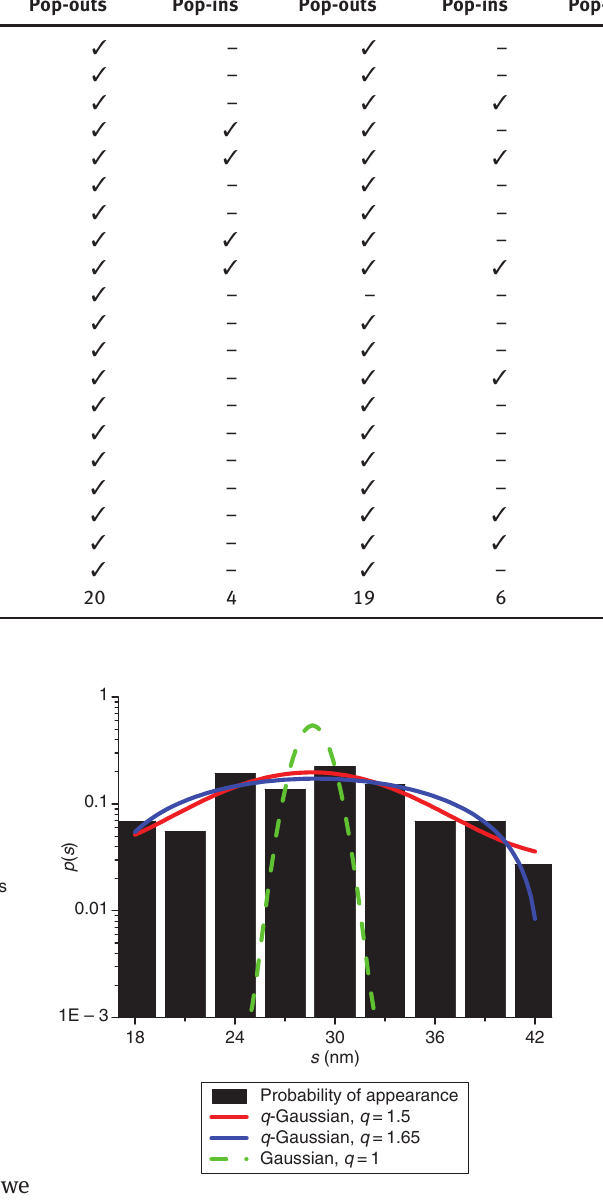
Figure 8: Probability distribution of the various pop out sizes appeared during nanoindentation procedure. The experimental data are fitted with the q -Gaussian probability density